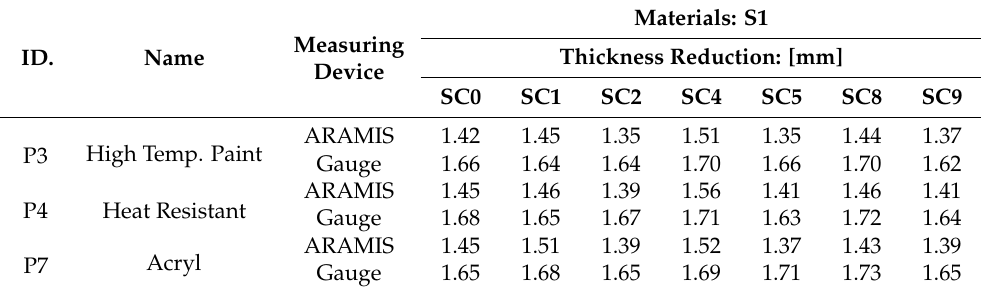
Table 13. Measurement results of usability tests.